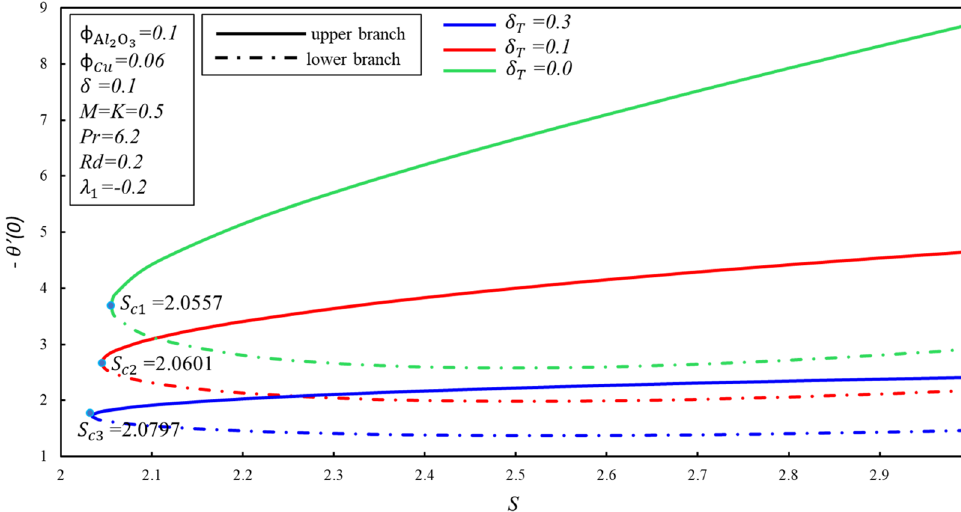
Figure 7. Behavior of